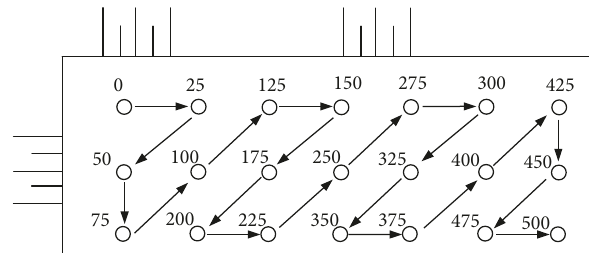
Figure 3: Initiation network and drilling holes pattern.